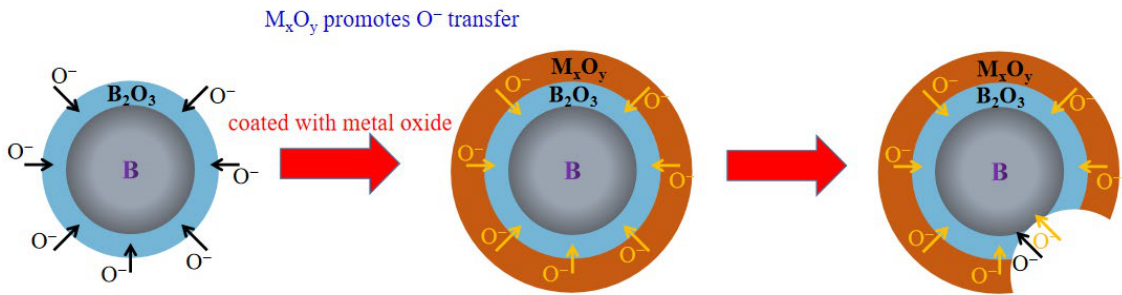
Figure 17. The reaction mechanism of B@M x O y